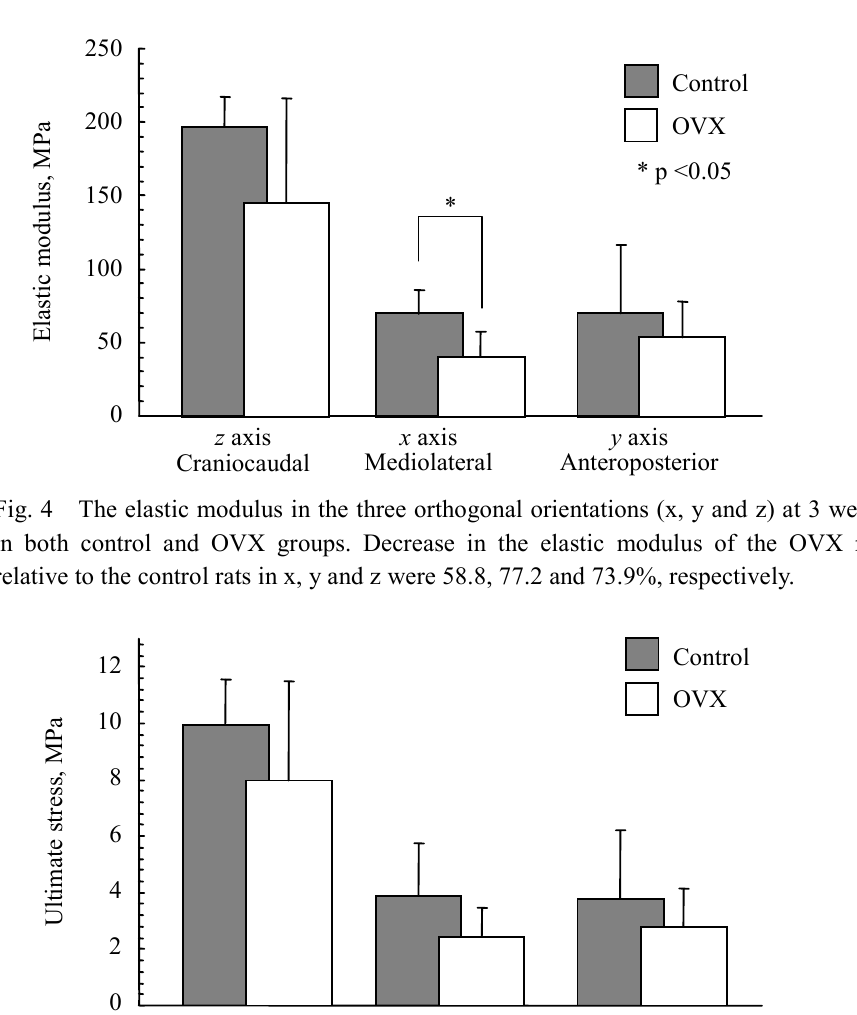
y axis x axis z axis Anteroposterior Mediolateral Craniocaudal Fig. 5 The ultimate stress in the three orthogonal orientations (x, y and z) at 3 weeks in both control and OVX groups. Decrease in the ultimate stress of the OVX rats relative to the control rats in x, y and z were 62.9, 74.3 and 80.1%, respectively.